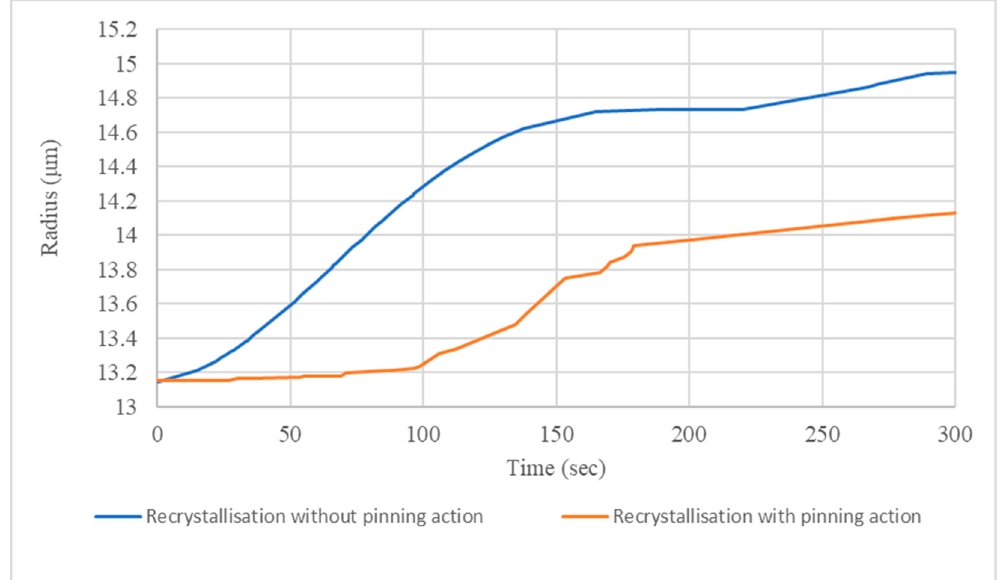
Figure 4. Evolution of the recrystallized grains average radius.